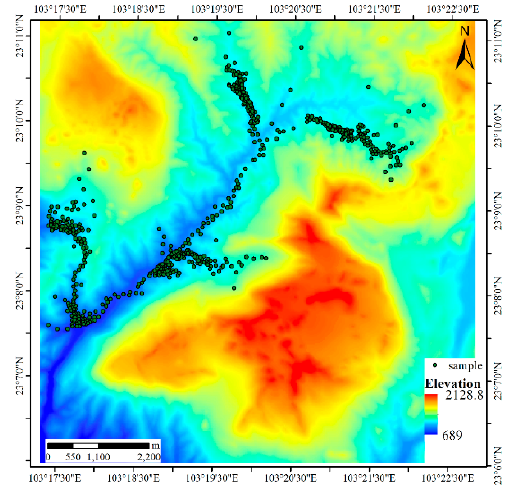
Figure 2. The rescued oriental white stork ( a ) and monitoring points in the spring ( b ).